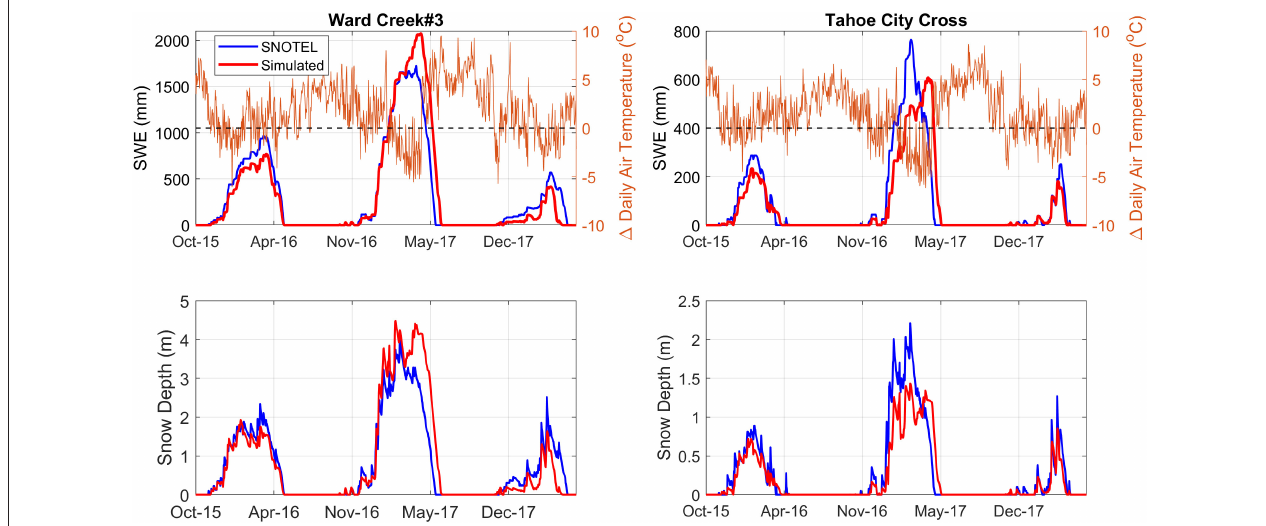
( Figure 3 ), resulting in some rainfall events being simulated as snowfall, leading to an overestimation of peak SWE. Despite the imperfect match against SNOTEL data, the validation is strong and consistent with previous studies (Harpold et al., 2020).